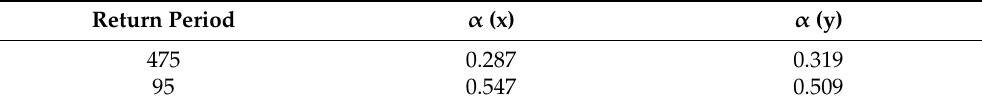
Table 3. The values of parameter α